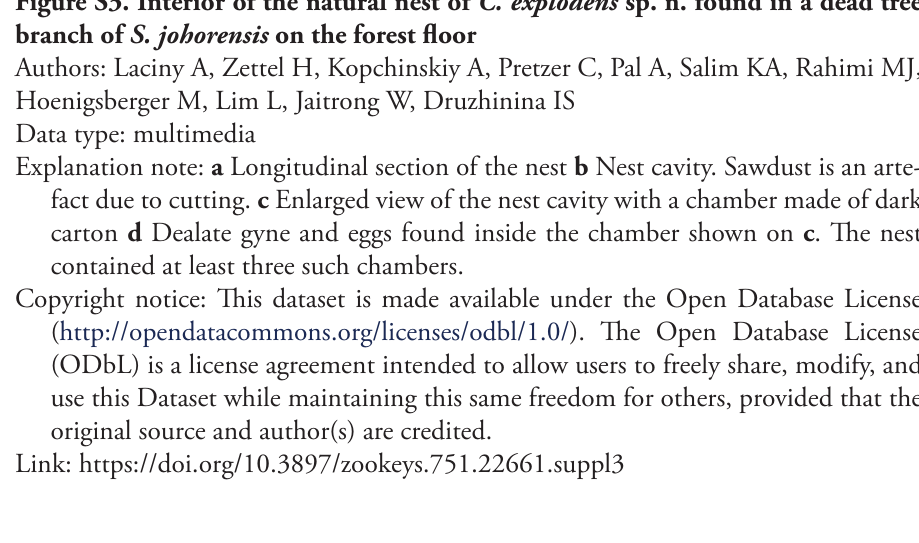
Figure S3. Interior of the natural nest of C. explodens sp. n. found in a dead tree branch of S. johorensis on the forest